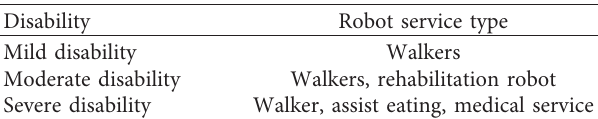
Table 2: Correspondence between disability and needs of robot service type